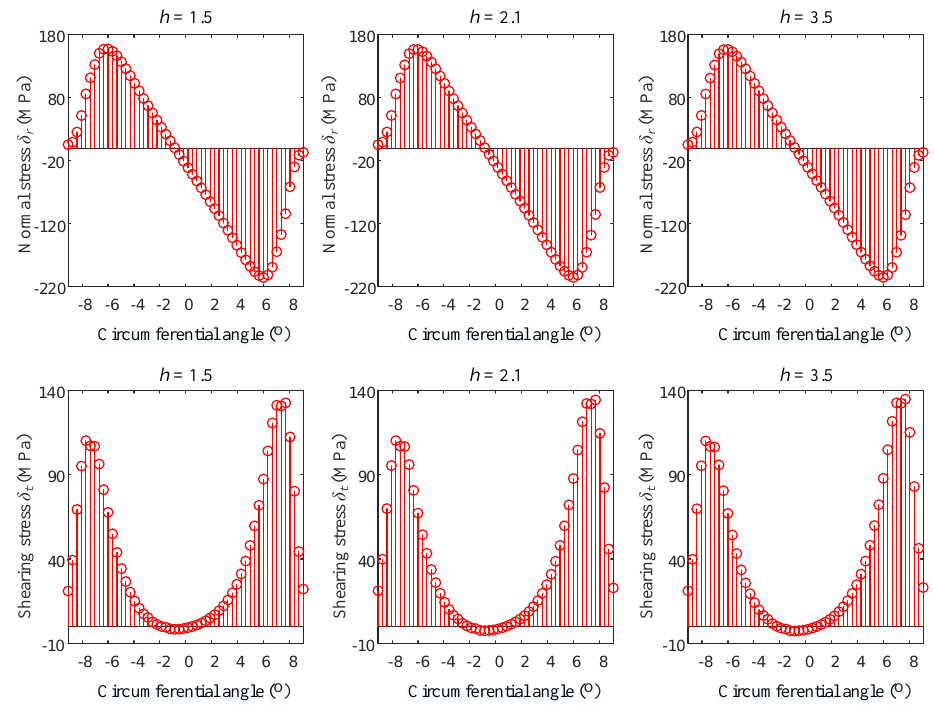
ff ect of gear bore size on tooth root stress Figure 10. Effect of gear bore size on tooth root stress distribution. Figure 10. E